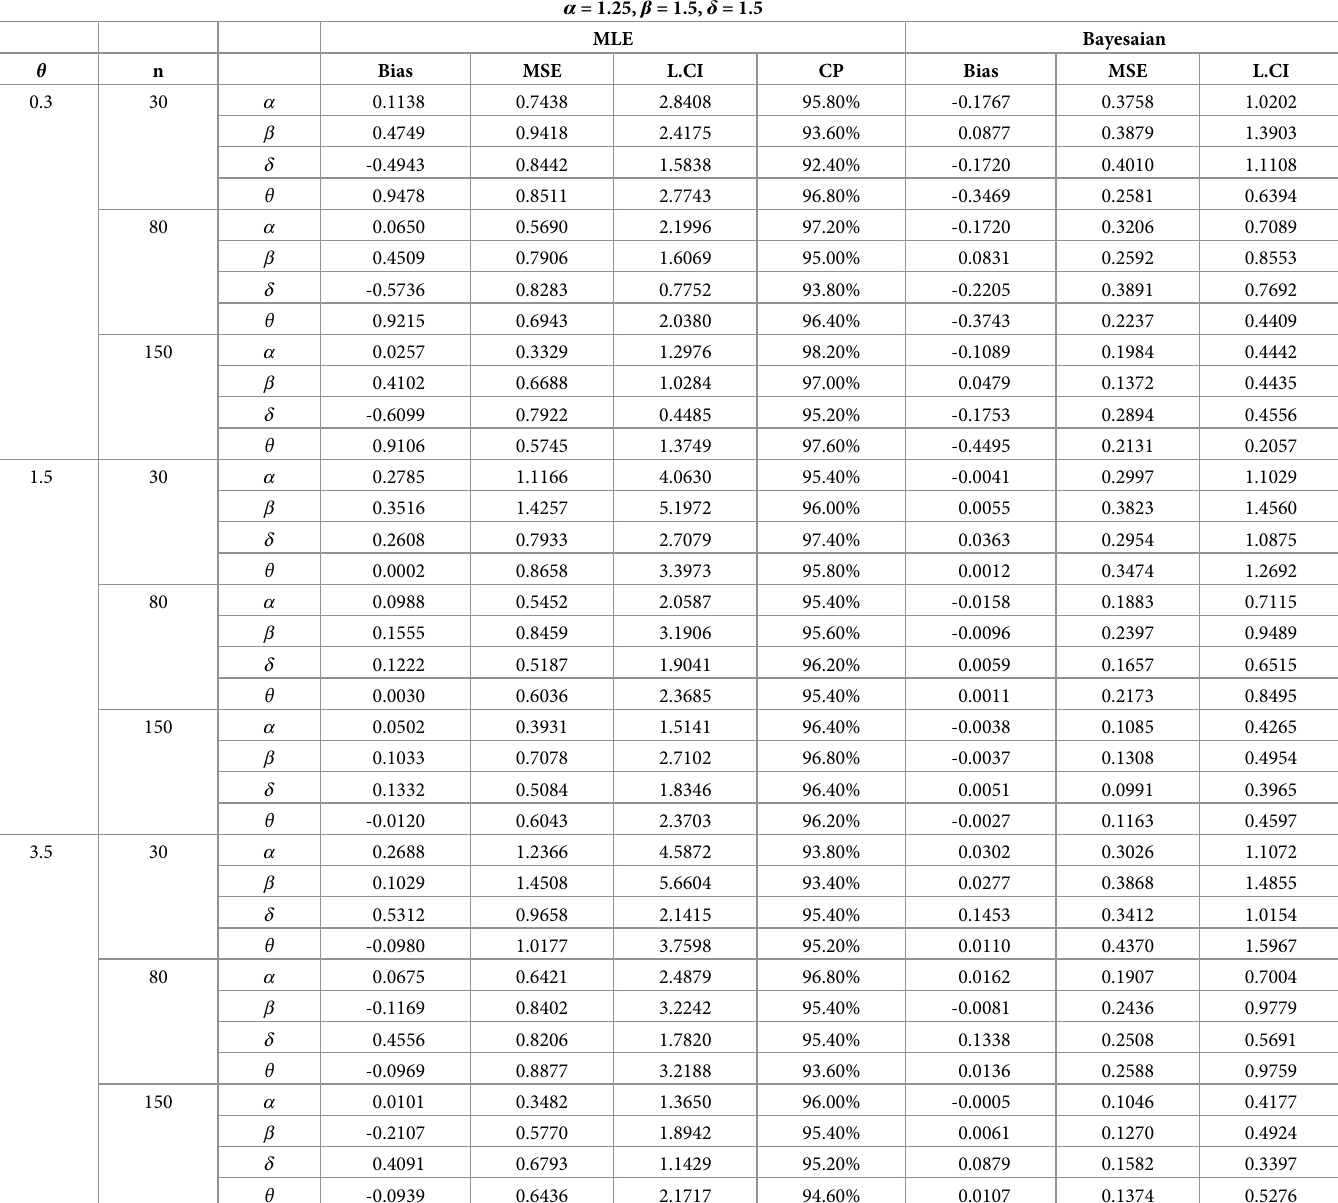
Table 1. RB, MSE, and length of CI of OLINH distribution for MLE, and Bayesian when α = 1.25, β = 1.5, δ =